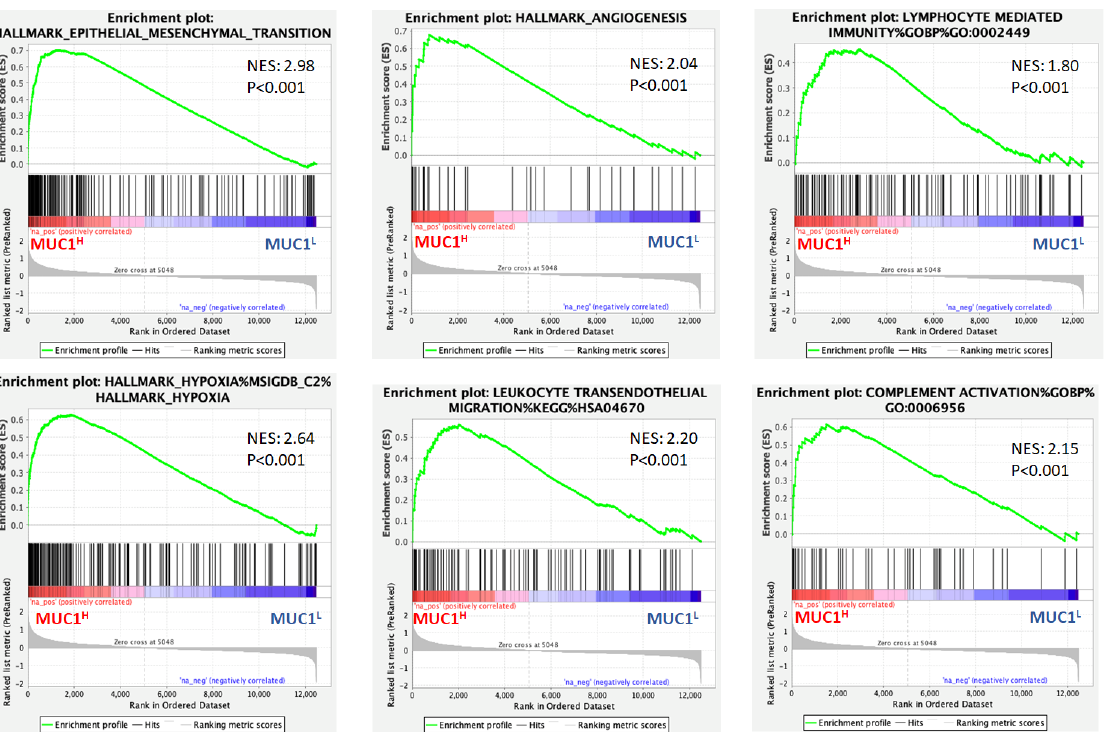
Figure 1. Gene set enrichment analysis (GSEA) of the GSE15641 dataset revealed that genes associated with MUC1 upregulation were significantly enriched in epithelial–mesenchymal transition, hypoxia, angiogenesis, complement system activation, and immune cell infiltration related processes. NES: normalized enrichment score.